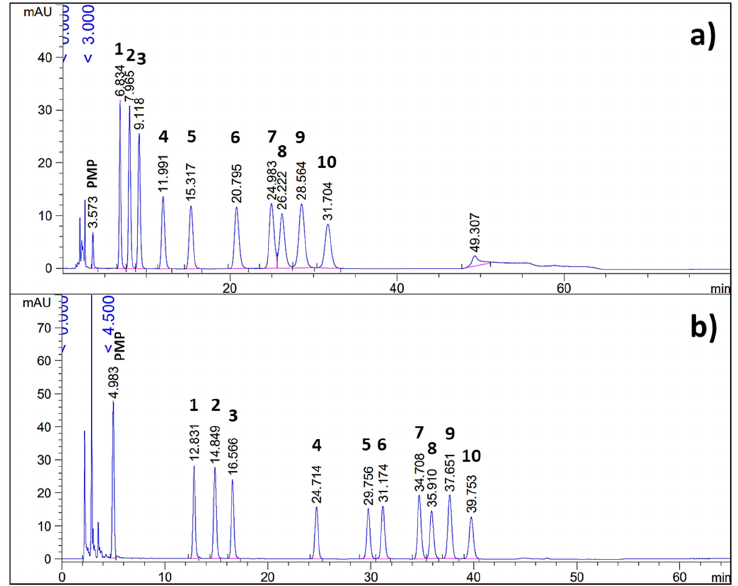
Figure 2. Chromatograms of 10 monomeric PMP–sugar derivatives: ( a ) analyzed by isocratic elution and mobile phase combining the buffer component at pH 8.0 and 15% acetonitrile (AcN) as the organic component; ( b ) analyzed by gradient elution and mobile phase combining the buffer component at pH 8.0 and AcN at 12–17%; 1-mannose, 2-ribose, 3-rhamnose, 4-glucuronic acid, 5-galacturonic acid, 6-glucose, 7-xylose, 8-galactose, 9-arabinose, 10-fucose (all PMP derivatives).